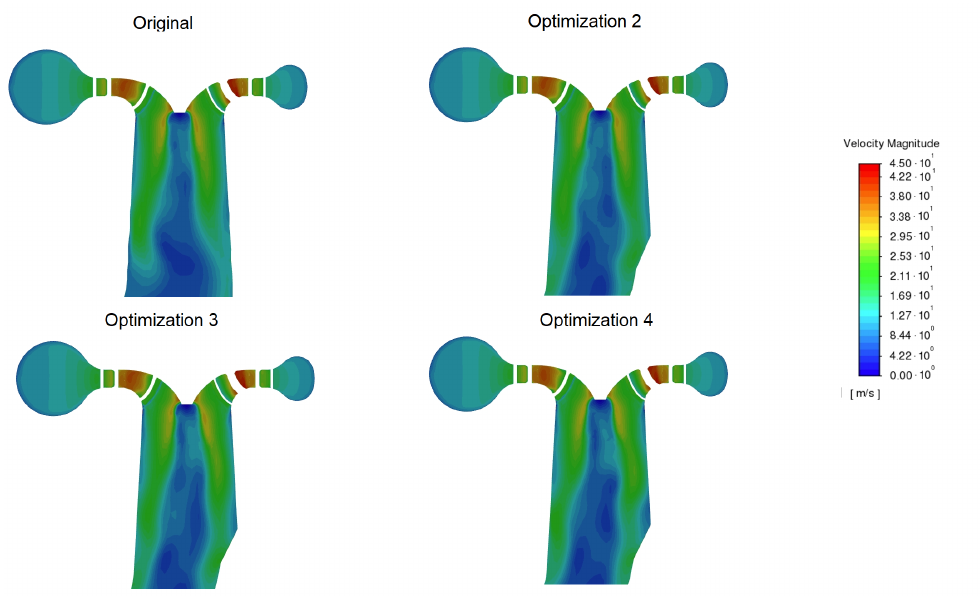
Figure A11. Detail of the velocity magnitude at the beginning of a draft tube for a 14.3 m 3 /s flow